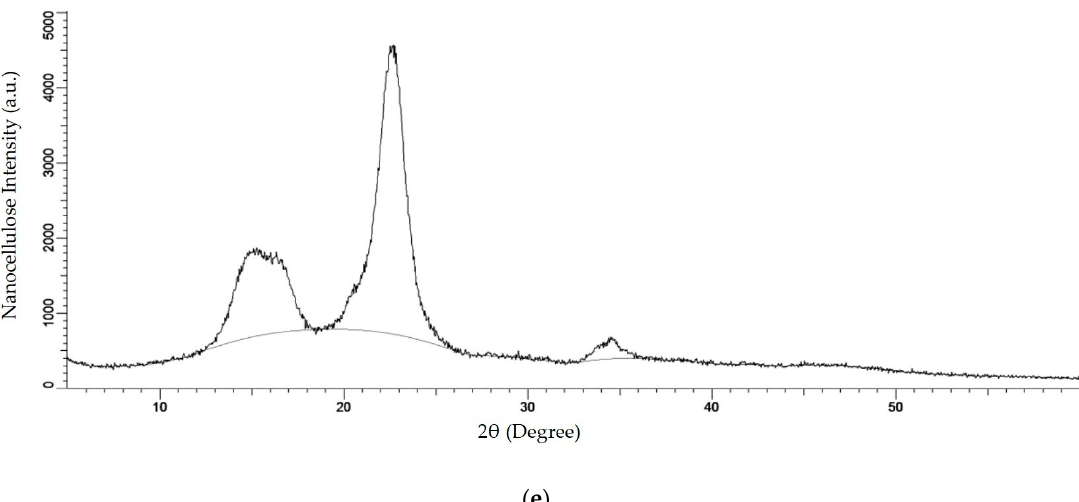
Figure 5. The XRD molecular pattern of ( a ) POC (Control); ( b ) 1 mL collagen with 1 mg nanocellulose (ColNc 1); ( c ) 1 mL collagen with 5 mg nanocellulose (ColNc 5); ( d ) 1 mL collagen with 10 mg nanocellulose (ColNc 10); ( e ) nanocellulose.